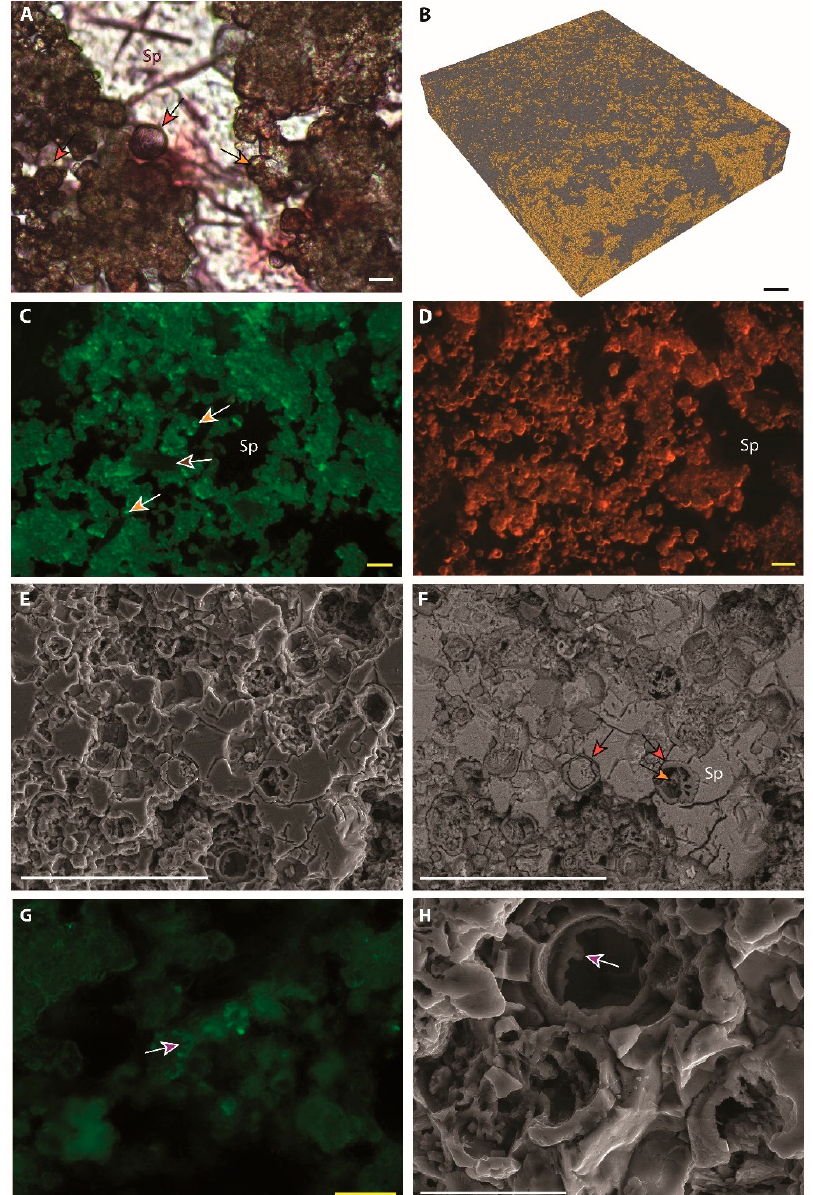
Figure 15. Microstructures (Table 2) of a large stromatolite hemispheroid sampled in the bed of Figure 6B. Sorbas, DS3. ( A ) is a plane polarized light image; ( B ) is a 3D CT scan reconstruction; ( C , G ) are reflected light fluorescence images; ( D ) is a cathodoluminescence image; ( E , F , H ) are SEM images, in secondary electron mode for ( E , H ) and back-scattered electron mode for ( F ). ( A ) The clusters are composed of brown dolomite microspheres, 10 to 20 μ m in diameter (red arrow), some with a nucleus (orange arrow). The scale bar is 20 μ m. ( B ) 3D internal fabric of the stromatolite. Primary dolomite (light orange) is organized in hundreds of micrometer clusters of microspheres and peloids, with secondary calcite spar developing in between (gray). The pixel size is 1 μ m; the scale bar is 100 μ m. ( C ) The microspheres show a green fluorescence with a locally bright nucleus (orange arrow), contrary to the spar cement (Sp) and the siliciclastic particles (mica; brown arrow). The scale bar is 50 μ m. ( D ) They have also an orange color in cathodoluminescence. The scale bar is 50 μ m. In ( E , F ), the microspheres have an external wall (red arrows) and sometimes a complex nucleus (orange arrow). The scale bar is 90 μ m. ( G , H ) show internal expansions on the dolomite wall of a sphere (purple arrow). The scale bars are respectively 40 μ m and 20 μ m.